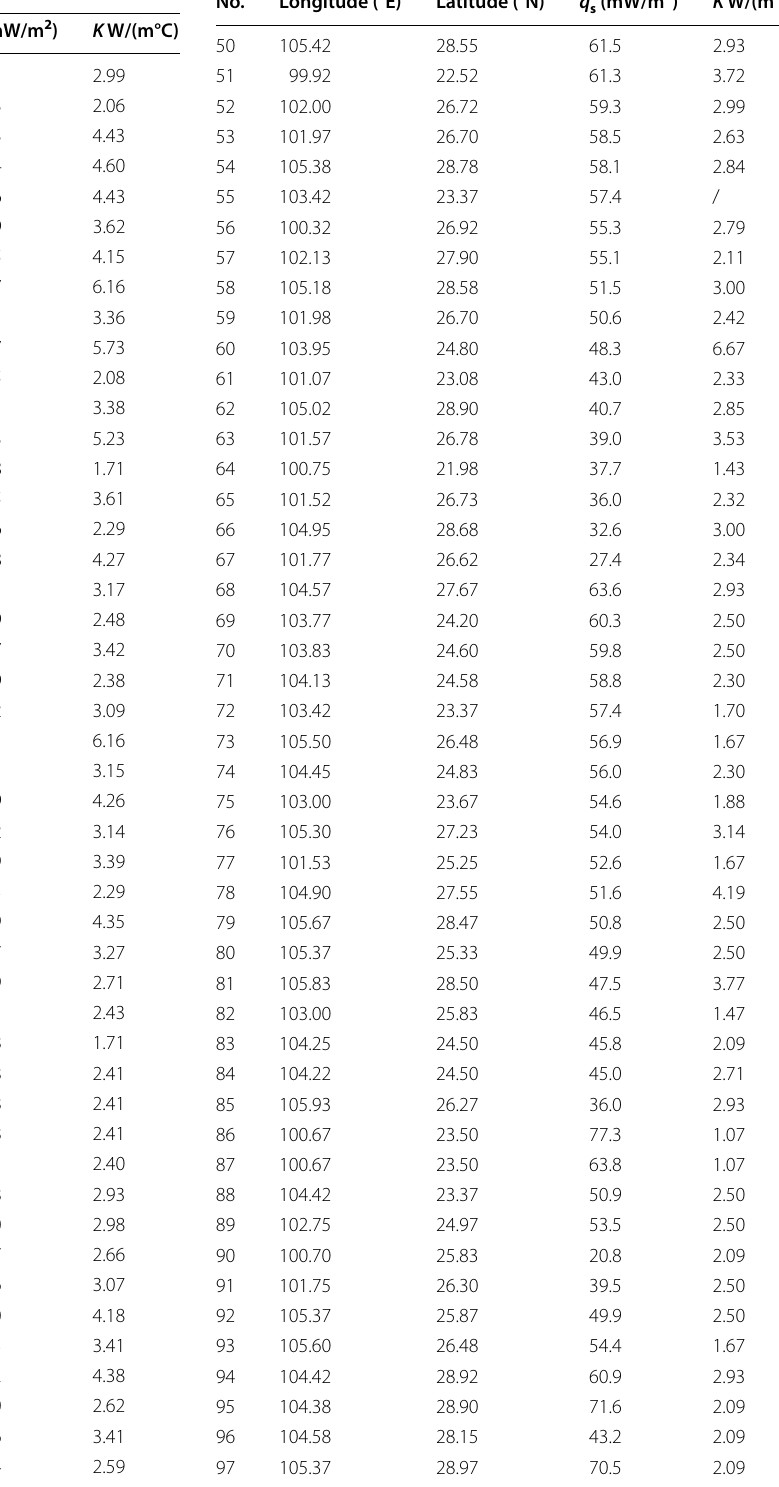
) and the thermal s